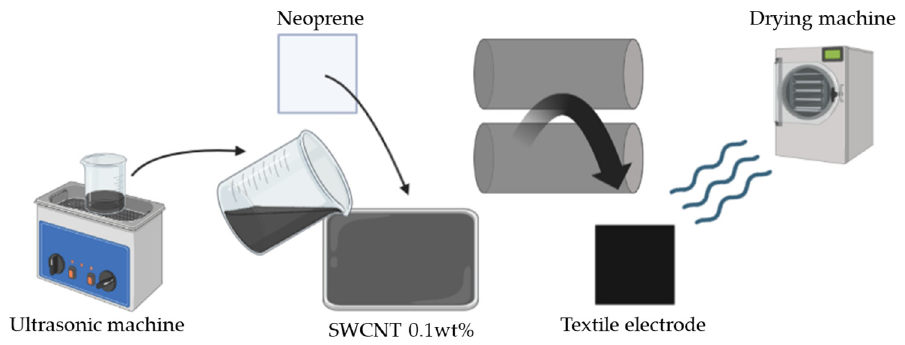
Figure 2. The fabrication process of the textile-based electrode.